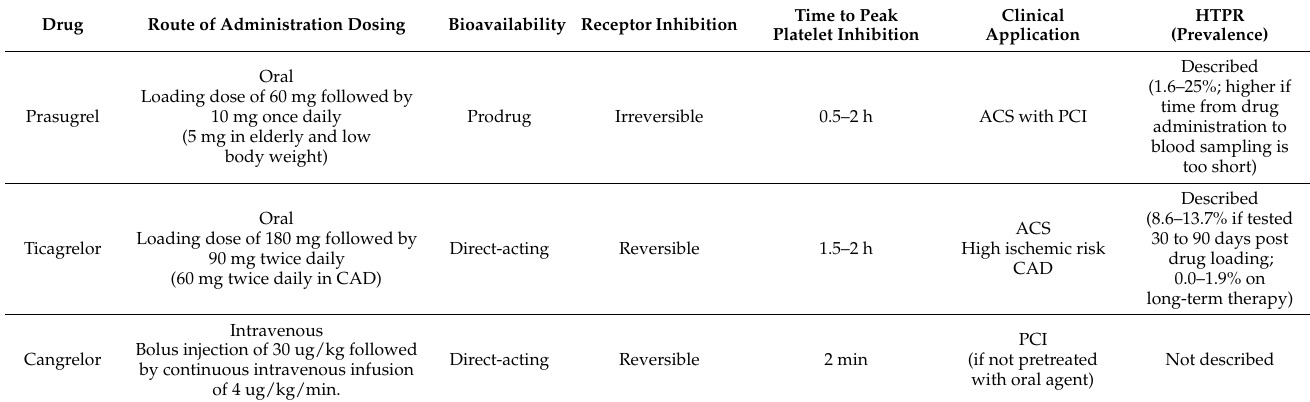
Table 1. Novel-generation ADP receptor blockers in current clinical